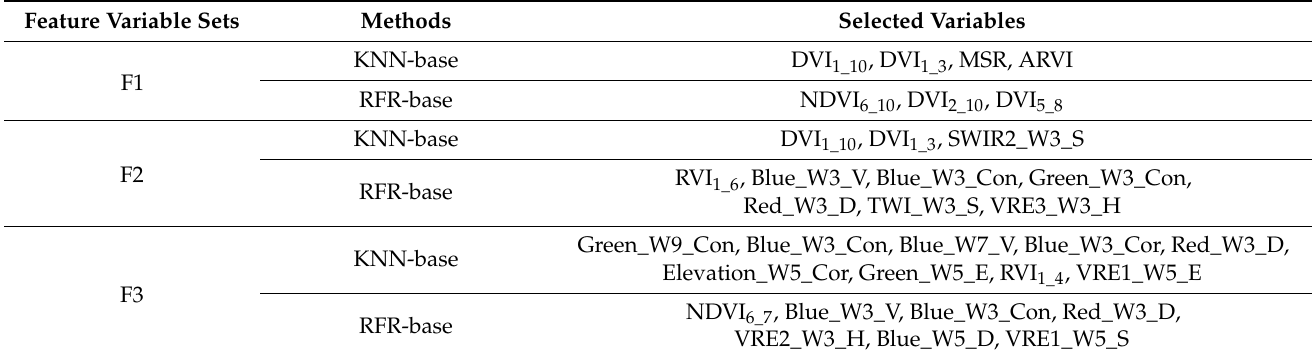
Table 6. Spectral variables selected from the NND_B3 image by different methods. W, Texture window size; VRE, vegetation red edge; M, mean; V, variance; H, homogeneity; Con, contrast; D, dissimilarity; E, entropy; S, second moment; Cor, correlation. For example, Green_W9_Con is expressed as a texture feature with the texture window size 9 × 9, GLCM- contrast, that is derived from the NND_B3 Green band